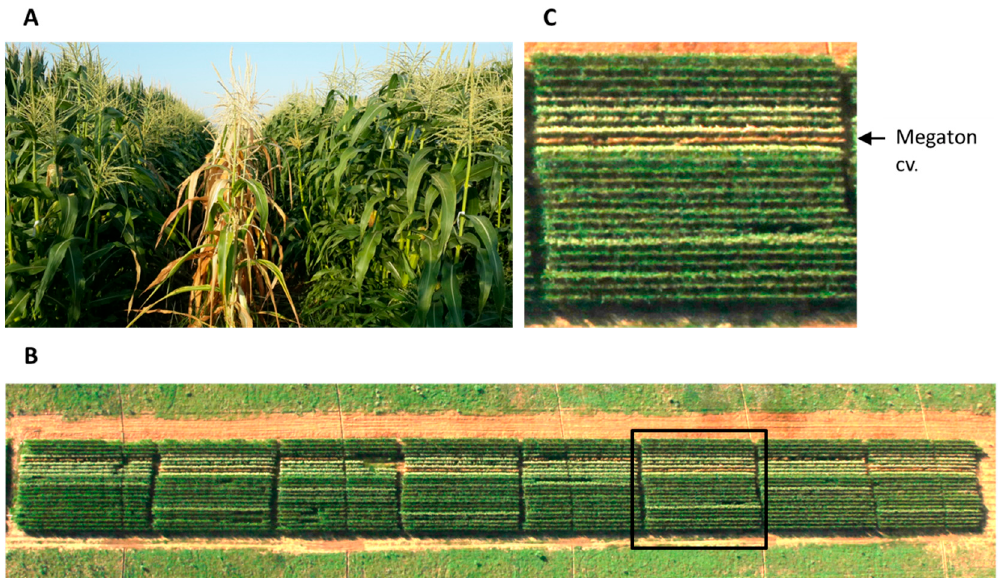
Figure 1. Field observation for assessing maize cultivars’ resistance/susceptibility to late wilt disease. The commercial maize field near Kibbutz Amir in the Hula Valley (Upper Galilee, northern Israel) was photographed 66 days after sowing (DAS), 10 days after fertilization (DAF, at July 30, 2017). ( A ). The wilted Megaton cv. plot. ( B ). An aerial photograph of the test field (photographed by Asaf Solomon). ( C ). Magnification of a portion marked by a black box in the whole field photo ( B ). The wilted Megaton cv. can be seen from the air as a brown strip.